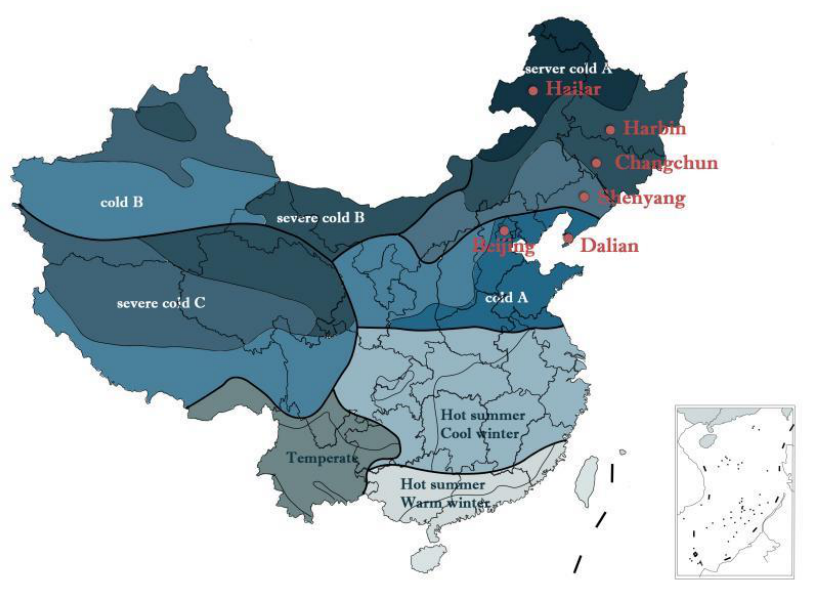
Figure 1. Location of the six case study cities in mainland China. (Source: Standard for building climate zoning GB 50178-93; drawn by the authors).